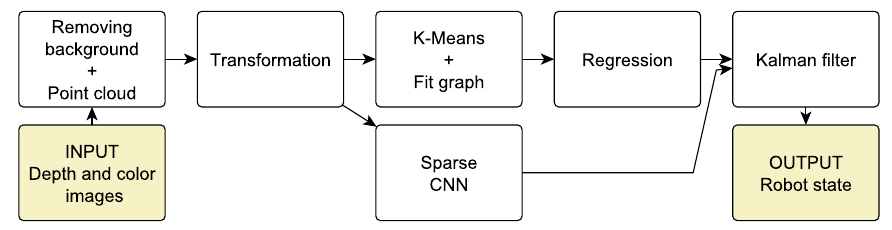
Figure 2. The sequence of the image preprocessing and tracking steps for graph fitting and a convolutional